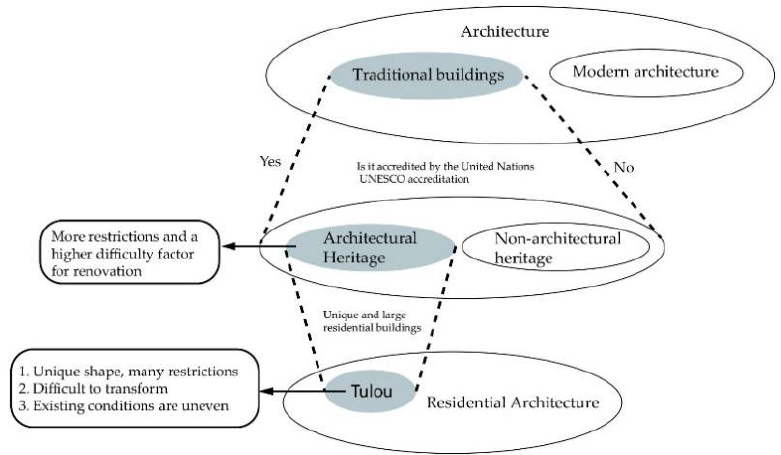
Figure 1. Types of research on Tulou buildings.